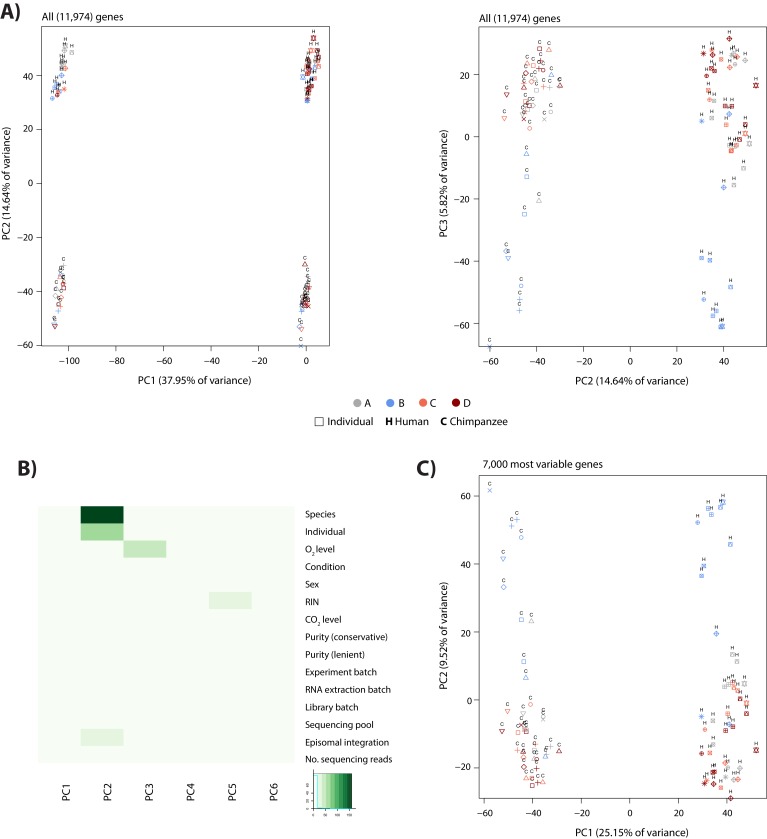
Species and individual are most correlated with the first two principal components in PCA.(A) PCA of the corrected RNA-seq count data (RUVs-normalized counts following removal of four factors of unknown variation) showing the first three PCs. Colours indicate condition, while shapes indicate the individual, which the samples came from. Human samples are designated by ‘H’ and chimpanzee samples by ‘C’. (B) Significance of the correlation between various biological and recorded technical factors and the first six principal components following PCA. –log10p values are plotted. (C) PCA including only the 7,000 most variable genes in the analysis.